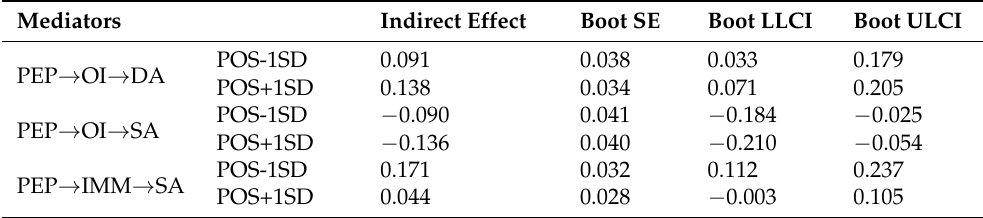
Figure 3. The moderating effect of POS on the relationship between PEP and impression manage- ment motive.